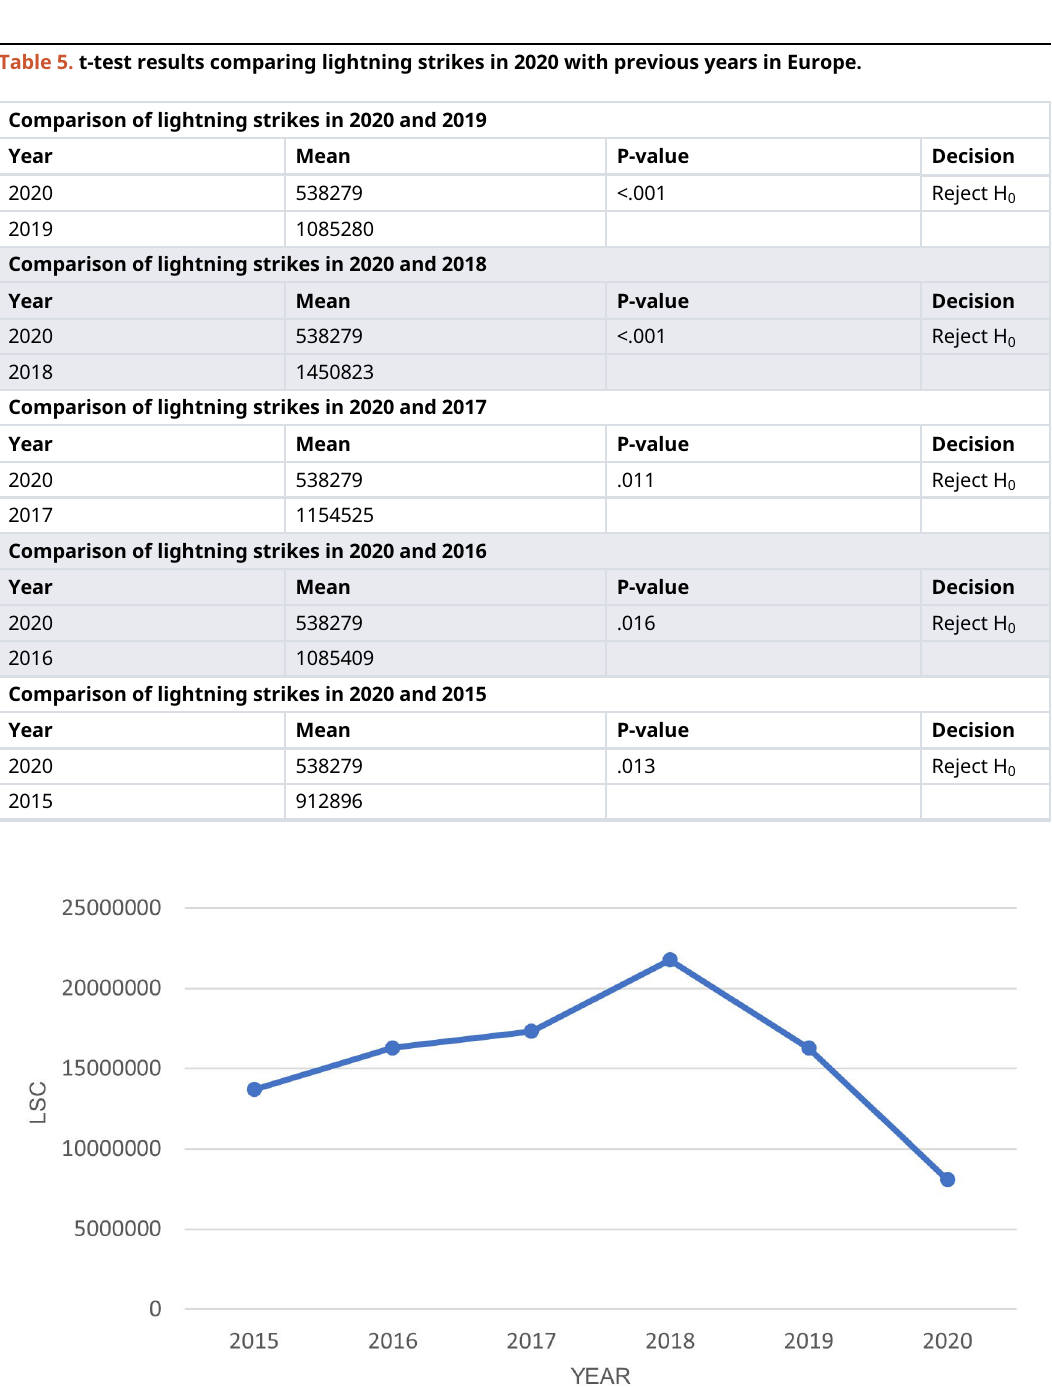
Figure 1. LSC in Europe from March-July in year 2015 –